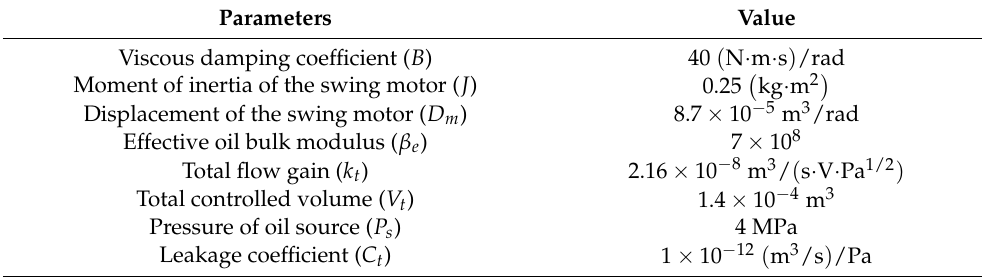
Table 1. System Parameters.